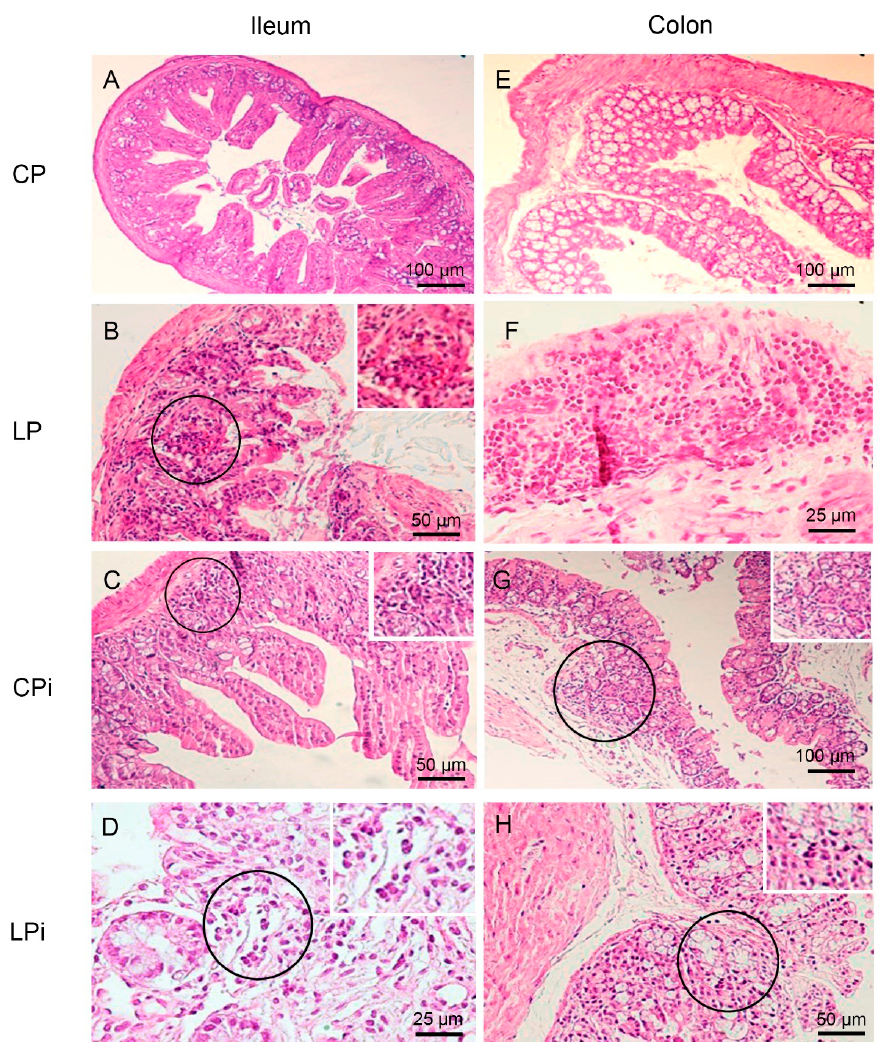
Figure 3. Histopathological analysis of ileum and colon from BALB/c mice. CP: animals fed 14% protein diet, LP: animals fed 4% protein diet, CPi: animals fed 14% protein diet and infected, LPi: animals fed 4% protein diet and infected. (A-D) Ileum. H&E. ( A ) CP mouse without histological alterations. ( B ) LP mouse showing mild and diffuse lymphocytic infiltrate (circle and inset) in the lamina propria. ( C ) CPi mouse showing mild and diffuse lymphoplasmacytic infiltrate (circle and inset) in the lamina propria. ( D ) LPi mouse showing moderate to severe and diffuse lymphoplasmacytic infiltrate (circle and inset) in the lamina propria. ( E – H ) Colon. H&E ( E ) CP mouse without histological alterations. ( F ) LP mouse showing moderate to severe and diffuse lymphocytic infiltrate in the lamina propria. ( G ) CPi mouse showing mild and diffuse lymphocytic infiltrate (circle and inset) in the lamina propria. ( H ) LPi mouse showing mild and diffuse lymphoplasmacytic infiltrate (circle and inset) in the lamina propria.